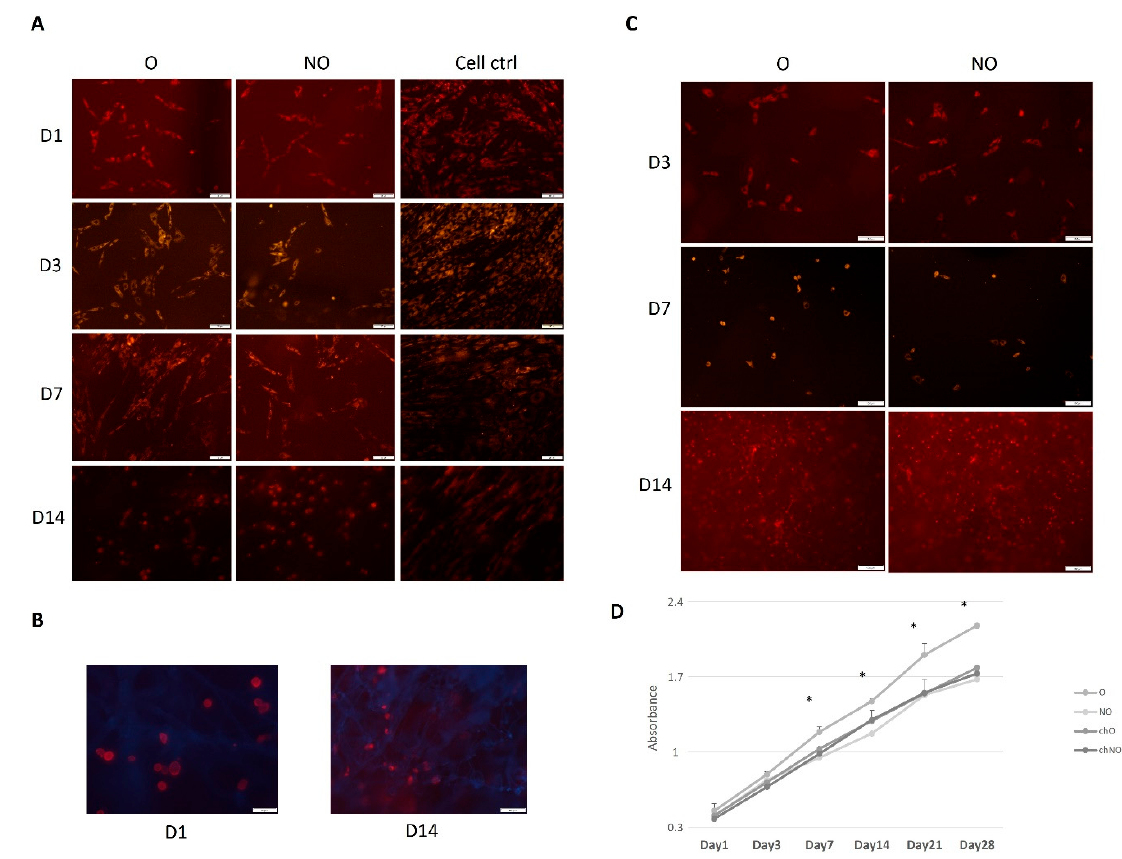
Figure 4. hMDSCs and hCH tracking ( A – C ) and proliferation ( D ) on “naïve” and ozone-treated PCL scaffolds. hMDSC and hCH were pkh-26-stained and followed for 14 days ( A – C ), blue color ( B )—stained with DAPI. Unstained cells were seeded, and cell proliferation was evaluated via CCK-8 until day 28. Results are presented as mean +/ − standard deviation. * represents p -value < 0.05. NO—